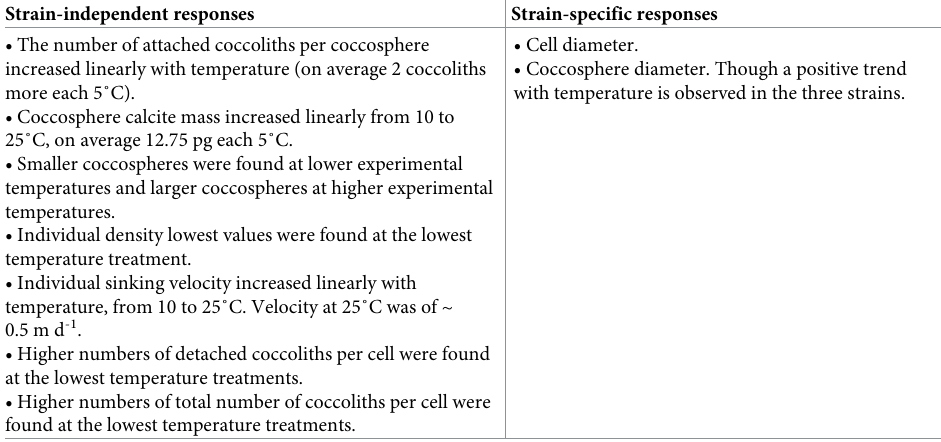
Table 5. Significant strain-independent and strain-specific responses of E . huxleyi to temperature, found in this